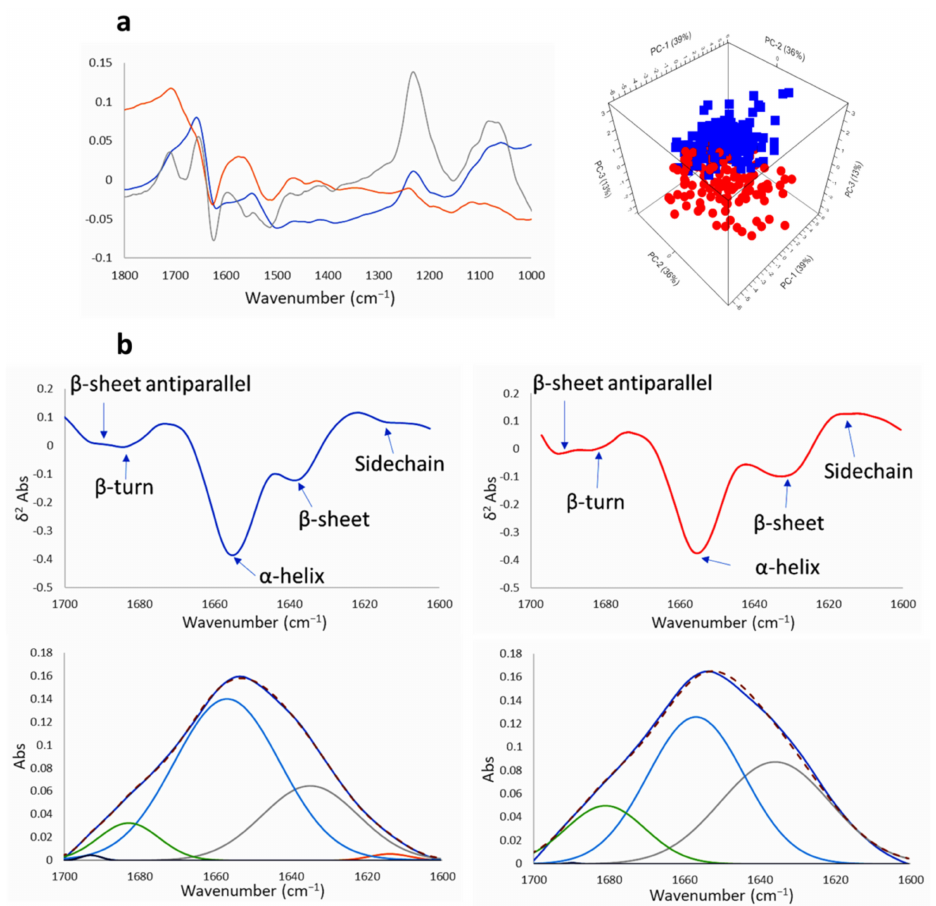
Figure 8. PCA and loadings within the protein region (1800–1000 cm − 1 ) of GIC7 cells treated with Na[ o -COSAN] 200 µ M, 5 h: ( a ) Principal component loadings (blue PC-1, orange PC-2, grey PC-3) and principal components analysis scores plot of PC-1, PC-2 and PC-3 displaying the variance between GIC7 control (blue) and GIC7 treated cells (red). ( b ) The second derivative